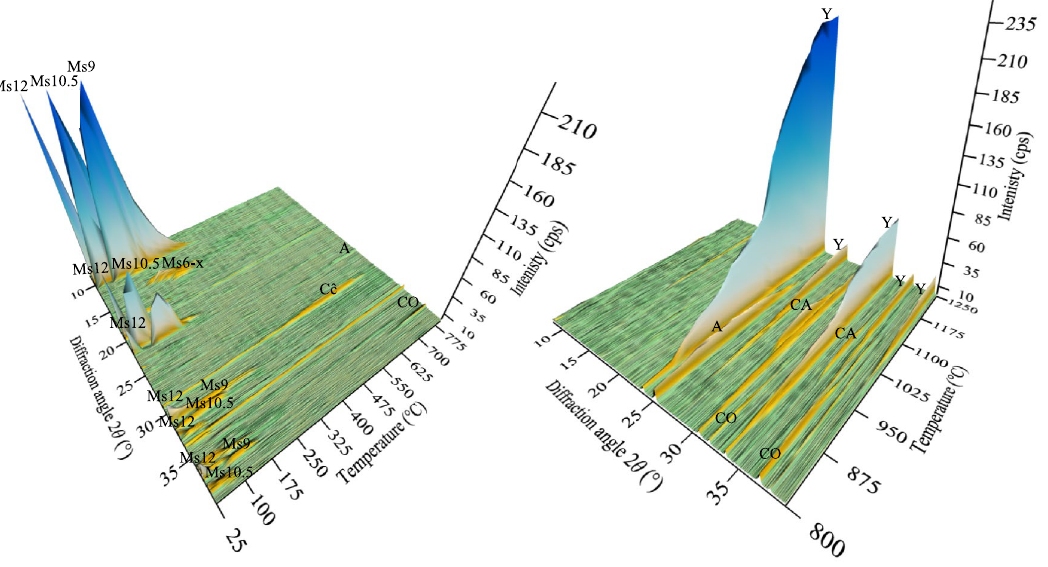
Figure 7. In situ XRD patterns of the synthesis products when the calcination temperature varied in a 25–1250 °C range. The X-rays with a wavelength of 1.5406 Å (CuKα radiation) were used. Indexes: Ms – monosulfoaluminate (the number shows water content); Cĉ – calcium carbonate; CO – calcium oxide; A – anhydrite; CA – calcium aluminate; Y – ye`elimite.